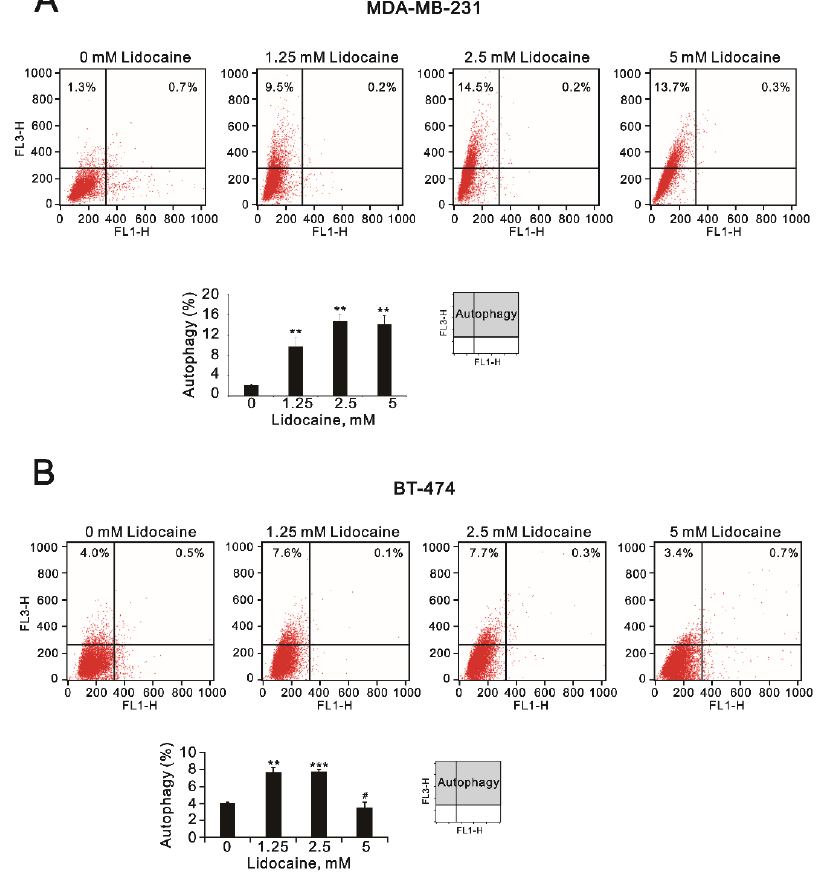
Figure 9. The effects of lidocaine on autophagy in MDA-MB-231 and BT-474 cells. Acidic vesicular organelles were detected and quantified using acridine orange staining and measured using flow cytometry analysis; ( A ) MDA-MB-231 and ( B ) BT-474 (3 × 10 5 ) cells were treated with the indicated concentrations of lidocaine (1.25, 2.5, and 5 mM) for 24 h. Acridine orange (1 µg/mL) staining was used to identify autophagic cells via FACS. The intensity of the red fluorescence (y-axis, FL3-H) was proportional to the degree of acidity and the volume of acidic vesicular organelles, including autophagic vacuoles. The values refer to the percentages of cells with a significant proportion of acidic vesicular organelles. The results are representative of two independent experiments. Bars depict the mean ± SD. # p > 0.05; ** p < 0.01; *** p < 0.001.